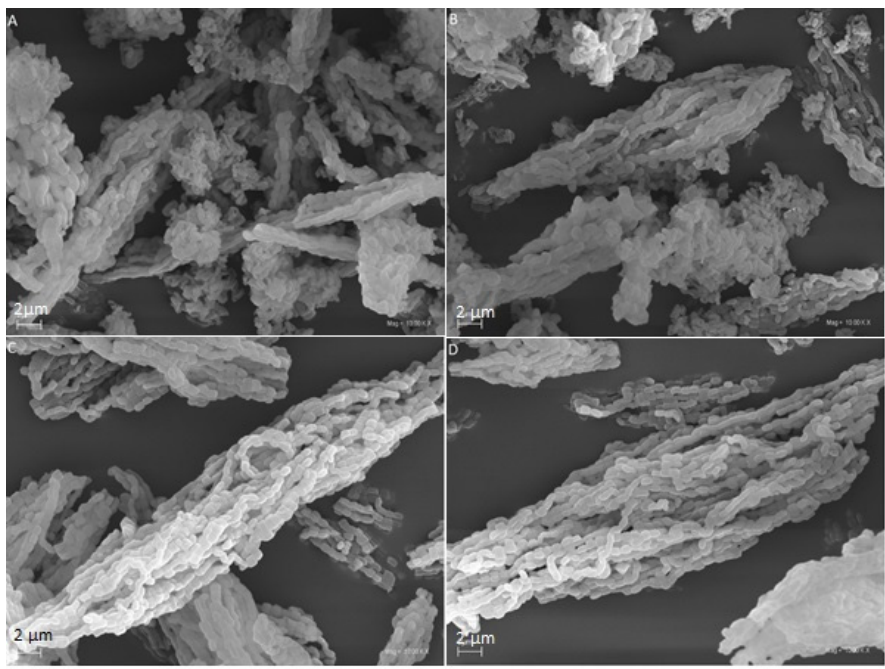
Figure 4. SEM images of ( A ) SBA ‐ 15 ‐ A 0.05 :SUL, ( B ) SBA ‐ 15 ‐ A 0.20 :SUL, ( C ) SBA ‐ 15 ‐ A 0.05 , and ( D ) SBA ‐ 15 ‐ A 0.20 . 15-A 0.20